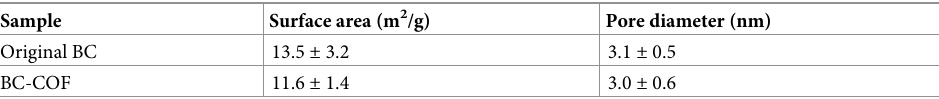
Table 3. BET surface areas and pore diameters of original BC and BC-COF bio-leather (Extraction conditions: Liquor ratio of 1:10 (w/v), coffee at an amount of 200 wt% BC, 90˚C, 1 h; dyeing conditions: Fabric-to-liquor ratio of 1:10 (w/v), 70˚C, 30 min, meta-mordanting with 1% of FeSO 4